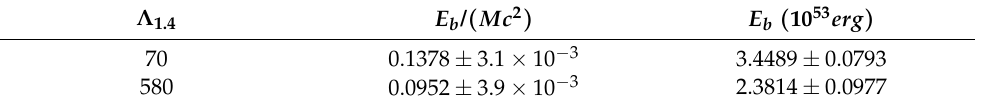
Table 3. Bounds on the binding energy of a 1.4 M (cid:12) neutron star, using Equations (32) and the data for Λ 1.4 from the analysis of the GW170817 event [37]. The 1 σ error for the fit is also included. Λ